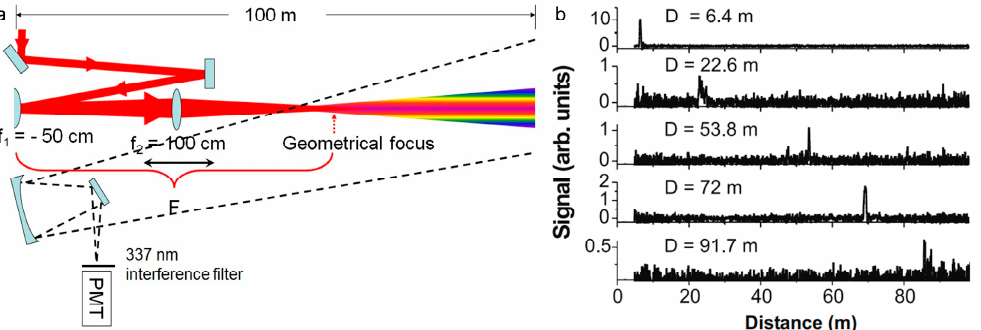
Figure 8. ( a ) Telescope system for generating long-distance filament, where PMT stands for photo- multiplier tube. ( b ) Collected backward fluorescence signals at different distances [142].